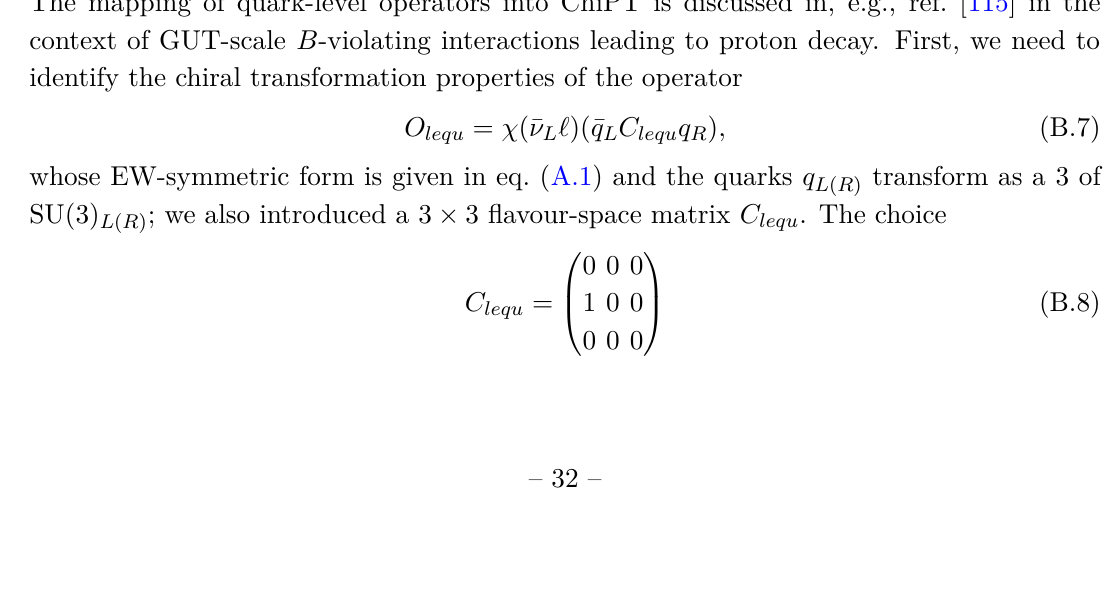
Figure 15 . Acceptance of searches from section 5 for χ → e model of appendix B.1 with Pythia . We consider a benchmark of m